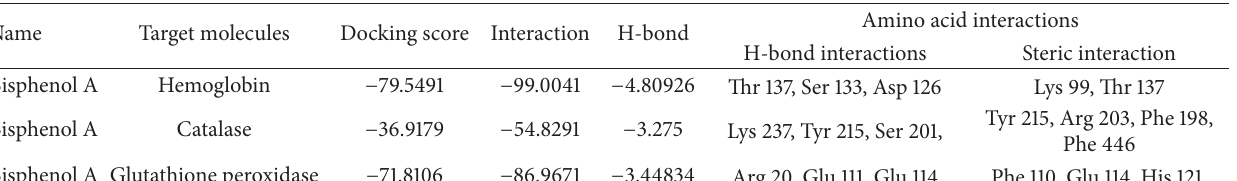
Table 5: Docking results of human erythrocyte (PDB id-2HHB), catalase (PDB id-1QQW), and glutathione peroxidase (PDB id-2F8A) with bisphenol A.